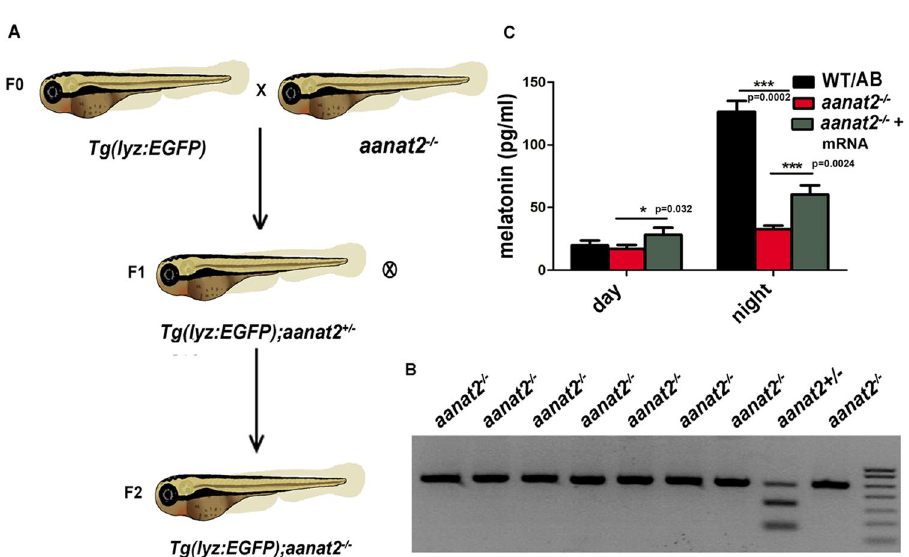
Figure 2. Establishment of a visual model for monitoring neutrophil migration in aanat2 − / − zebrafish. ( A ) Hybridization of transgenic line Tg ( lyz:EGFP ) labeling neutrophils and aanat2 mutants for two consecutive generations. ( B ) In F 2 zebrafish, we identified the homozygous aanat2 − / − transgenic zebrafish. Extracted genomic DNA from the tail fin of screened transgenic zebrafish was amplified using PCR and digested using the MspI enzyme. The uncleaved band indicated homozygous zebrafish. ( C ) To evaluate the functional effect of Tg ( lyz:EGFP ) ;aanat2 − / − zebrafish, we measured melatonin levels using an ELISA. Fifty larvae were homogenated and then melatonin was extracted using methanol as an individual sample (IBL international, Germany). The experiment used three samples. Results indicated that melatonin was significantly decreased at night compared with WT/AB larvae. The melatonin content could be partly rescued by injection of aanat2 capped mRNA (control, n = 50; mutant, n = 50; mutant + mRNA, n = 50) (ANOVA analysis). ( *** P <